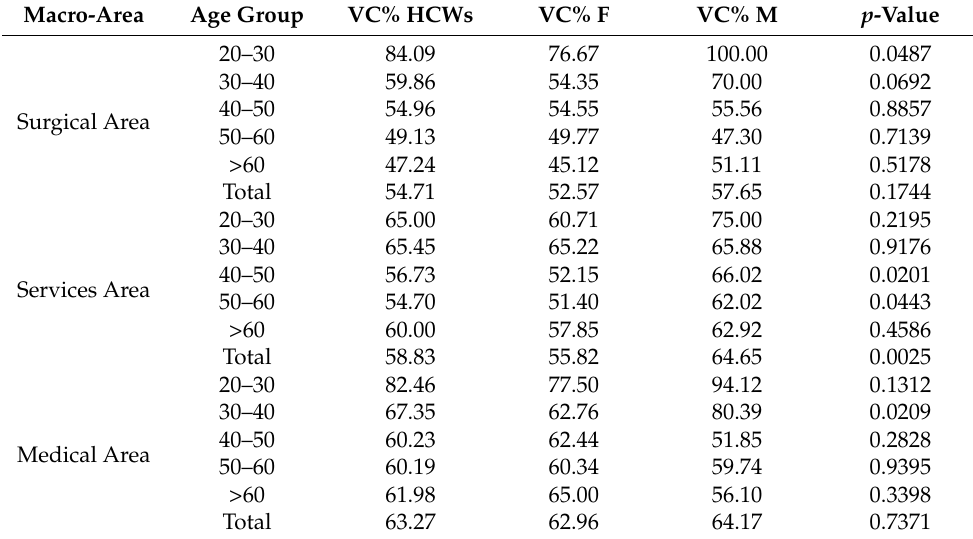
Table 7. Distribution of vaccination coverage (VC%) by marco-area of affiliation, age group, and gender (F = females; M = males) of healthcare workers (HCWs) who are receiving the influenza vaccination.